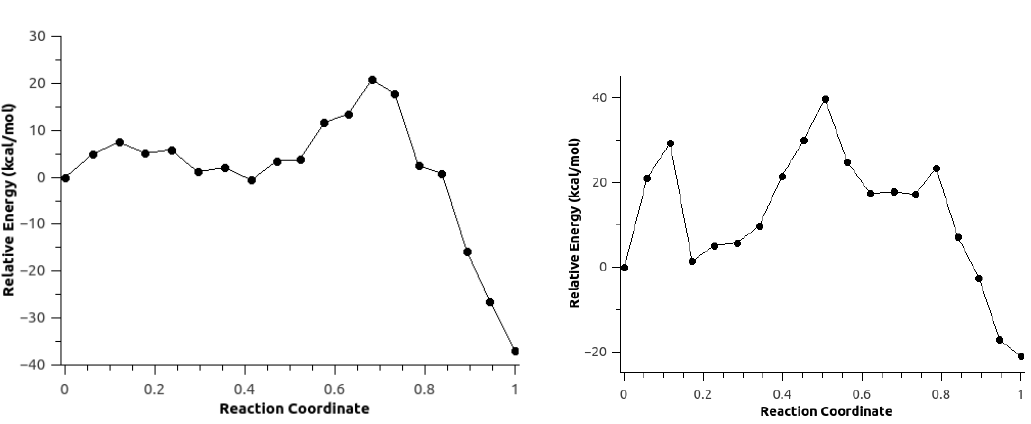
Figure 11. Minimum energy path for Scheme 1c ( right ) and d ( left ) for Configuration C2 without the AMOEBA polarization